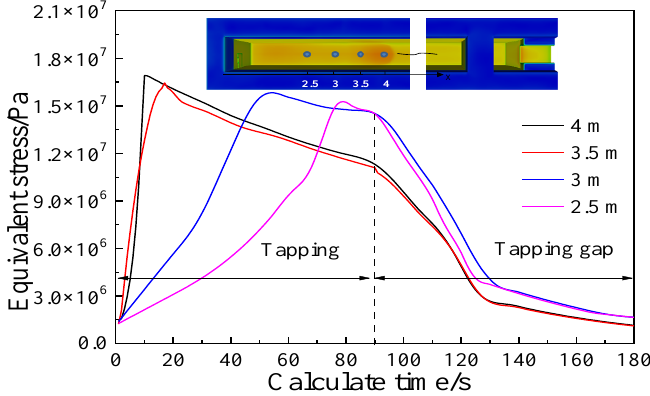
Figure 13. Stress curve of key points during tapping. Based on the analysis of the shear force and thermal stress, it is concluded that the refractory material on the bottom of the main trough experiences greater thermal stress during the tapping process, and the maximum thermal stress occurs at 4 m on the bottom of the main trough. Therefore, key points for further analysis are selected at this position and in nearby areas in order to observe the stress changes in a working cycle. After calculating the tapping process (which lasted 90 s in the simulations), an equally long period (“tapping gap”) without hot metal supply was simulated to study the working state of the main trough during the tap cycle. This gave the stress curve depicted in Figure 13.